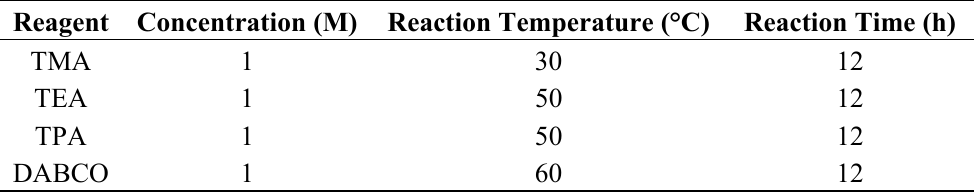
Table 2. Recipes for quaternization of each functional group on the base membrane.